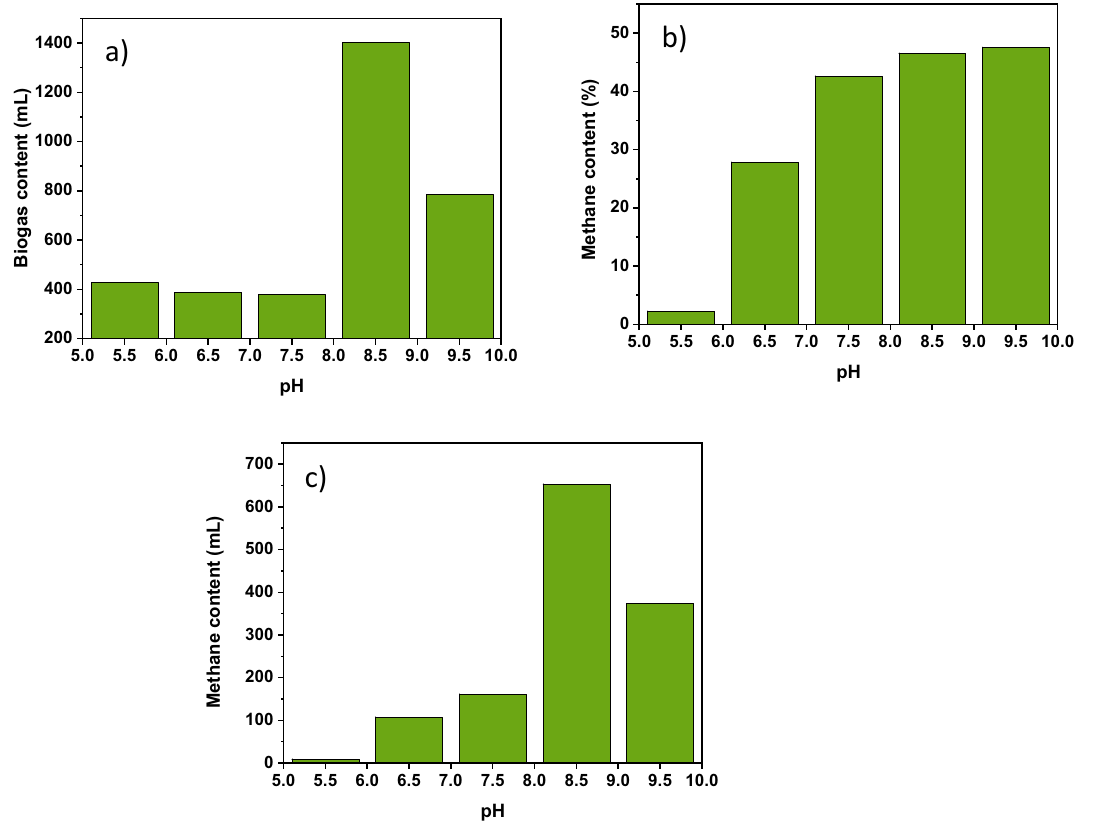
Figure 3. ( a ) Biogas production (mL) as a function of pH, ( b ) methane content (%) as a function of pH, ( c ) methane content (mL) as a function of